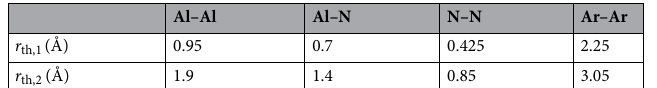
Table 1. Threshold values r th,1 and r th,2 for tapering COMB3 2022